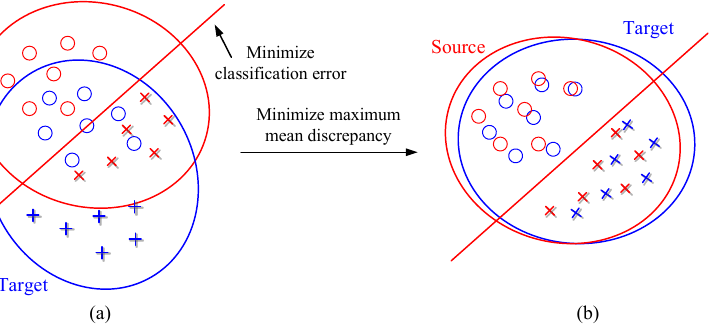
Figure 1. ( a ) The classifier cannot work well on both biased datasets. ( b ) The classifier can be transferred to the target domain by minimizing the